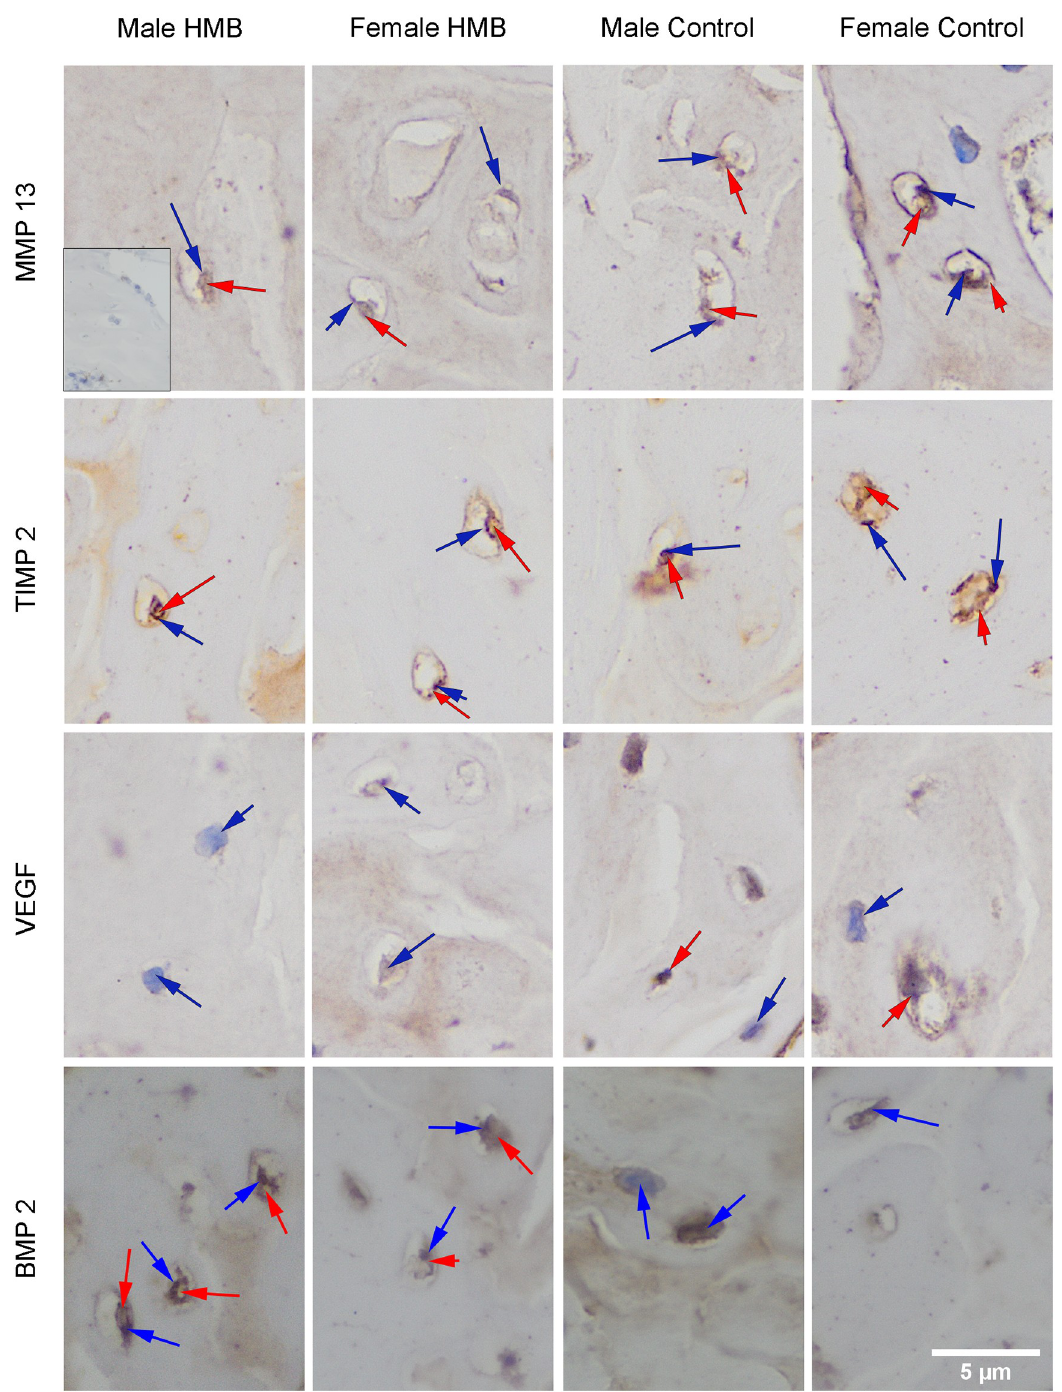
Fig 2. Imunstohistimechmic analysis of the expression the MMP13 (matrix metalloproteinase 13), the TIMP2 (tissue inhibitor of metalloproteinases 2), the VEFG (vascular endothelial growth factor) and the BMP2 (bone morphogenetic protein 2) from the humerus trabeculae. Representative images immunohistochemical analysis carried out on the formaldehyde-fixed from the humerus growth cartilage of newborn piglets. The positive reaction (presence of MMP13, TIMP2, VEFG, BMP2) in the cytoplasm or the cell nucleus was marked in red, while the lack of expression was marked in